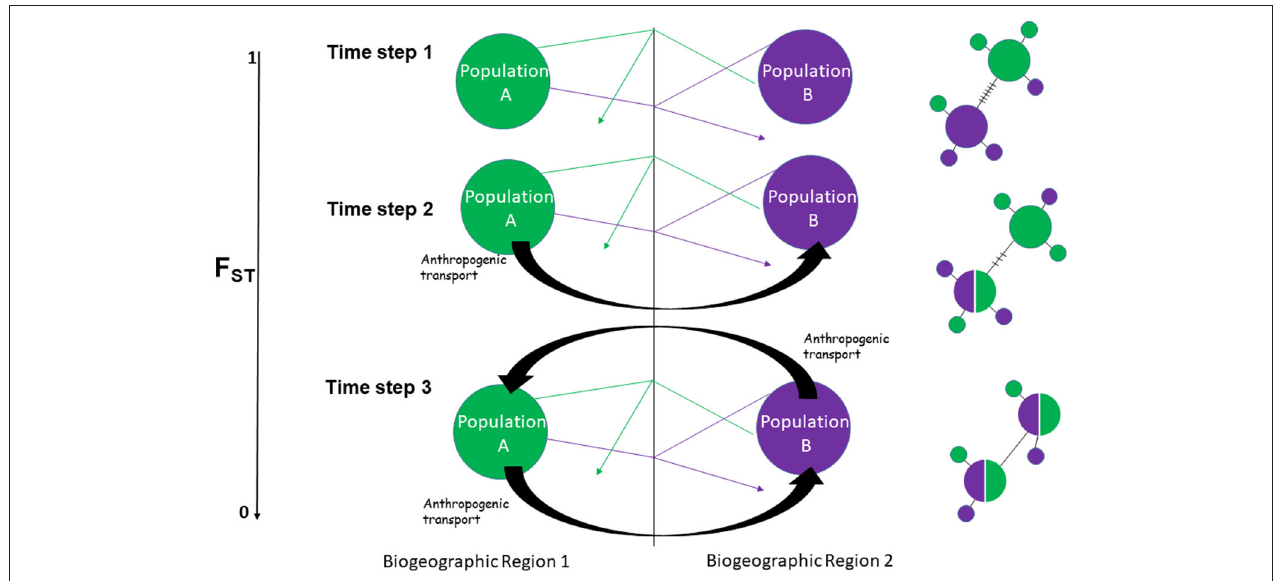
FIGURE 1 | Simplistic hypothetical scenario showing how consistent bi-directional anthropogenic movement of individuals across a dispersal barrier alters genetic patterns to mimic a panmictic seascape. Time step 1–natural dispersal without introductory events, Time step 2–natural dispersal coupled with unidirectional introductory events, Time step 3: natural dispersal coupled with bidirectional introductory events. Thin arrows represent natural movement of individuals, within each biogeographic region, in addition to leakage across a barrier, while thick black arrows represent anthropogenic transport. Fst (LEFT) is a standard population genetic parameter for measuring genetic differentiation between populations with 0 indicating low genetic structure (high levels of gene flow) and 1 indicating completely separate populations (low levels of gene flow). Hypothetical haplotype networks (RIGHT) shows the effects of introductory events on haplotype patterning from highly structured (time step 1) to panmixia (time step